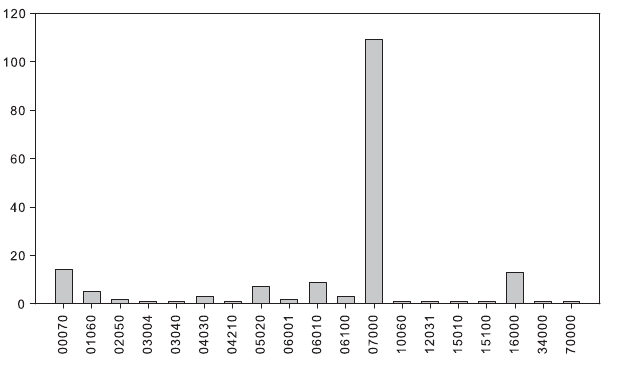
FIG. 6. Distribution of response vectors for Fall 2006 posttest